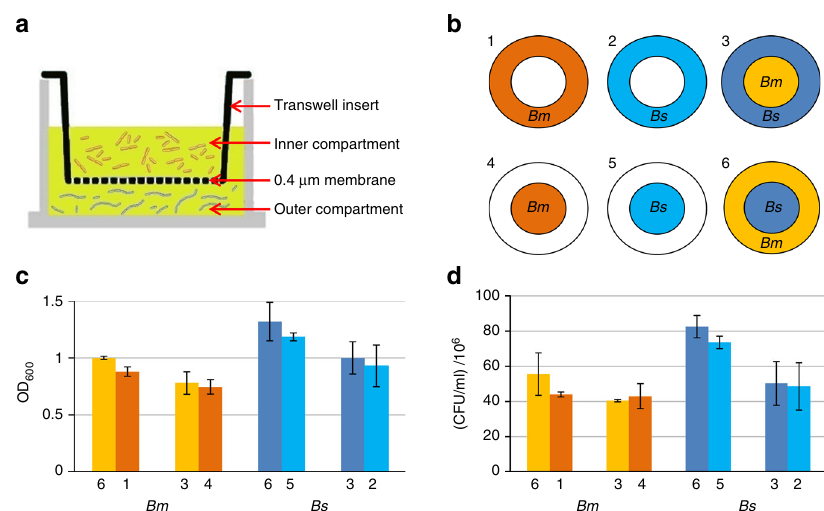
Fig. 2 Bs inhibits Bm growth in a contact-dependent manner. a Illustration of a single Transwell chamber. The medium is shared between the inner and outer compartments, while the cells cannot pass the 0.4 μ m membrane barrier. b Bs (PY79) and Bm (OS2) cells were grown in Transwell chambers containing LB as indicated by the layout. Compartments containing Bs are shown in blue hues , while compartments containing Bm are shown in yellow hues . White circles represent compartments containing LB only. c , d Shown are OD 600 ( c ) and CFUs ( d ) of cells grown in Transwell chambers for 6 h. The numbers and colors correspond to the layout described in b . Each column represents an average value and s.d. of three independent